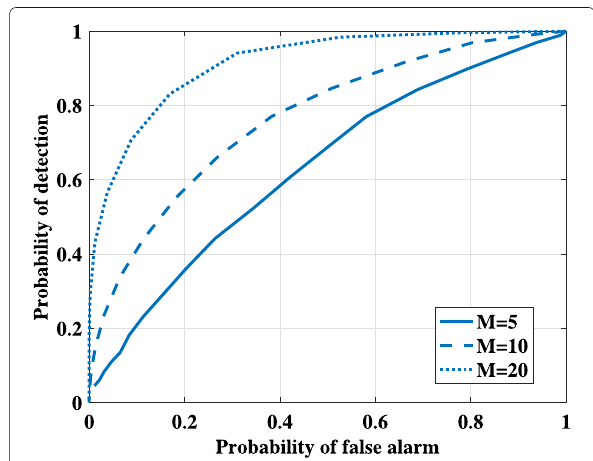
Fig. 6 Probability of detection versus probability of false alarm for N = I = 3 and b sp 0 = 10 3 × [5,5]